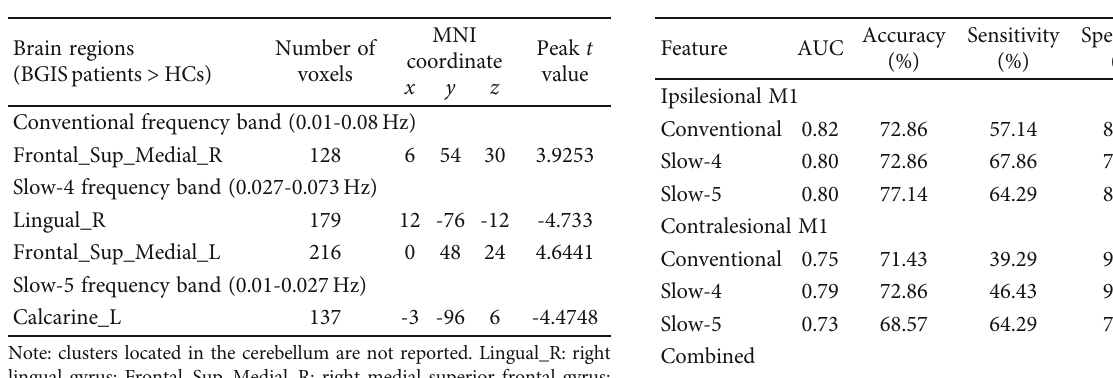
Figure 2: The functional connectivity alterations of the contralesional M1 in the three frequency bands. Table 3: The functional connectivity alterations of the Table 4: The results of a single or combined features in SVM contralesional M1 in the three frequency bands. Classi fi